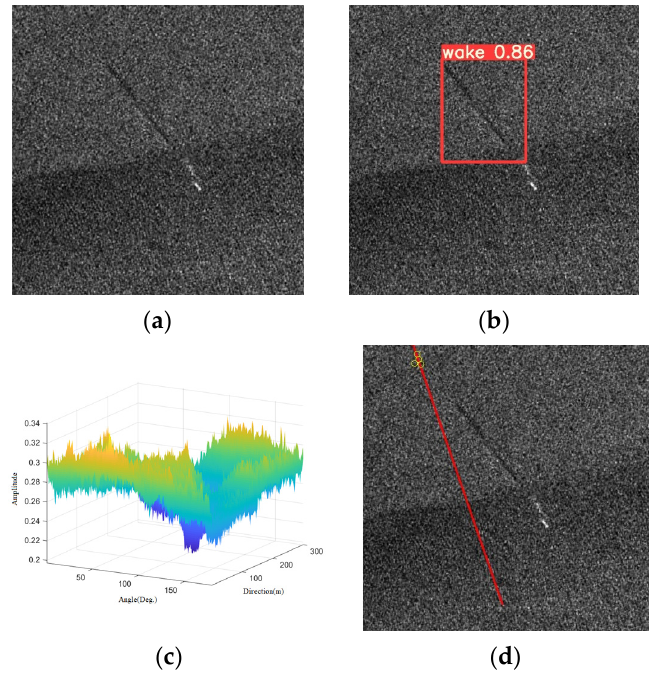
Table 6. Comparison of detection effects between YOLOv5 and the Radon transform.